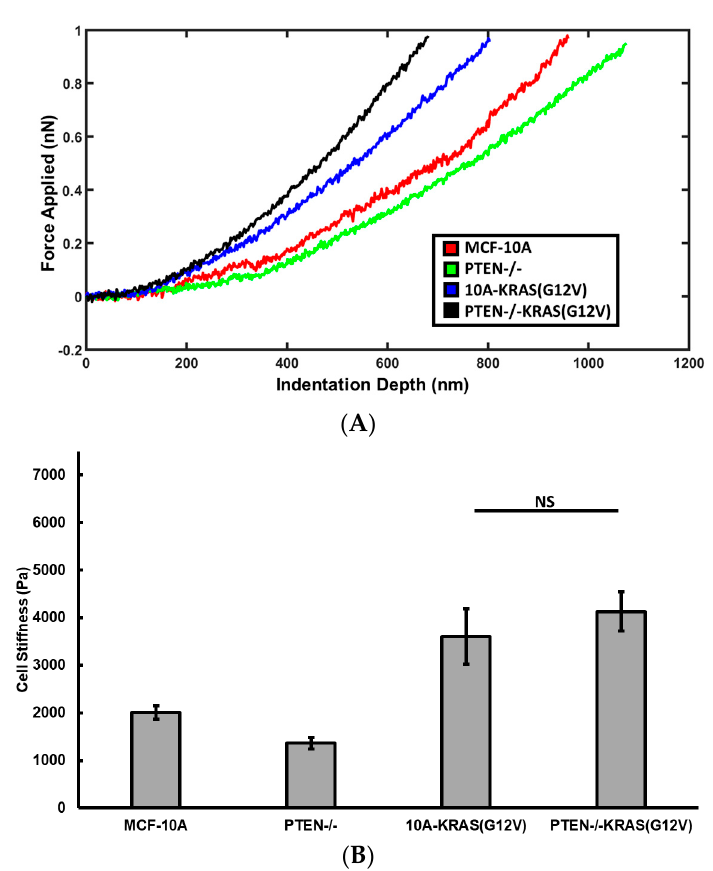
Figure 2. ( A ) Force curve examples that are representative of the average stiffness of MCF-10A, PTEN − / − , 10A-KRAS(G12V), and PTEN − / − KRAS(G12V) cells seeded on glass surface; ( B ) Average cell stiffness of cell seeded on glass surfaces. Number of cells measured: n = 16–35. NS signifies non-significant differences between two groups ( p > 0.05).